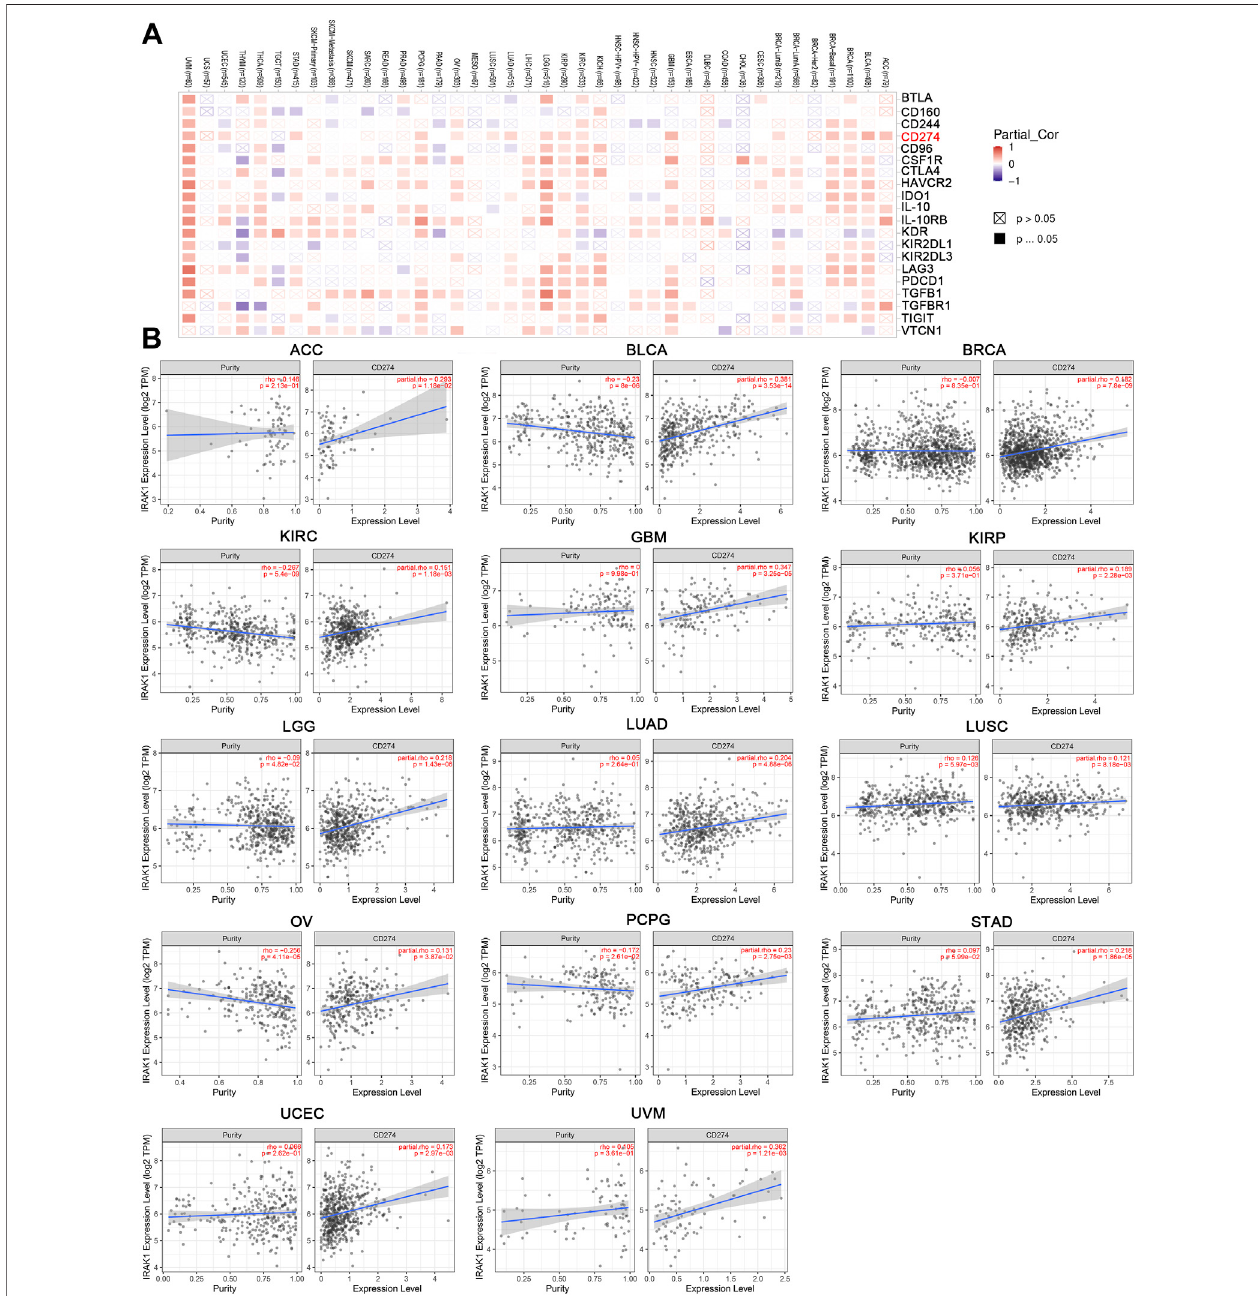
FIGURE 6 | IRAK1 expression is associated with immune checkpoint-associated genes in pan-cancers. (A) Heatmap representation of the correlation between IRAK1 expression and immune checkpoint-associated genes across pan-cancer types. (B) IRAK1 expression was positive associated with CD274 expression in ACC, BLCA, BRCA, KIRC, GBM, KIRP, LGG, LUAD, LUSC, OV, PCPG, STAD, UCEC and UVM analyzed by using